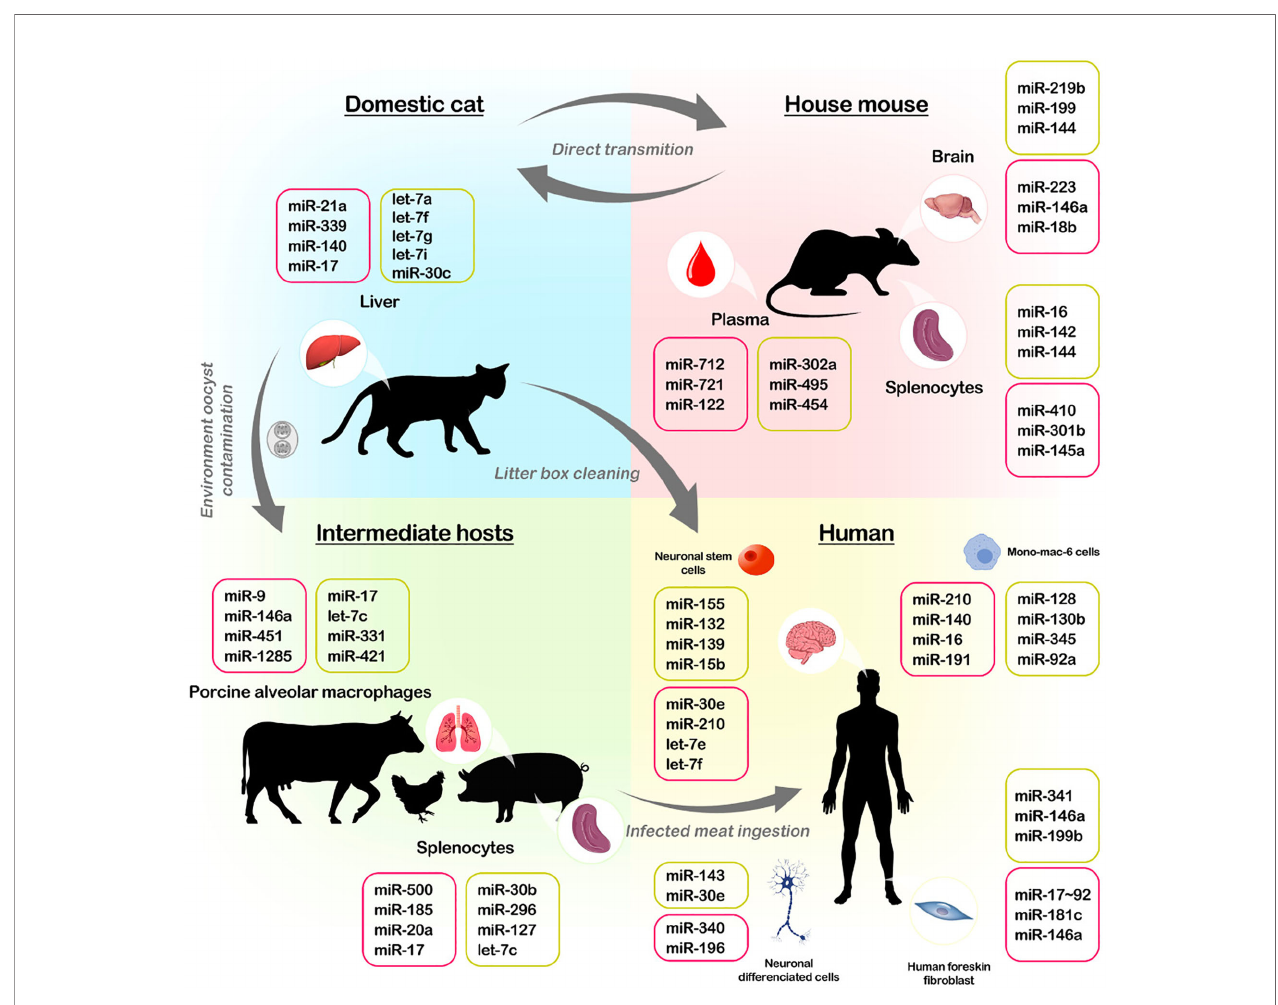
FIGURE 2 | Life cycle of Toxoplasma and host miRNA interaction. T gondii has a complex life cycle, in which the parasite can infect felids (domestic cats), farm animals, mice, and even humans. Felids are de fi nitive hosts. Oocysts are released from infected cat faeces and become infected in the environment after sporulate. Infected felids present modi fi cations in microRNA expressions. Humans become infected by ingestion of undercooked meat of infected animals or by the ingestion of soil, water or food contained sporulated oocysts derived from the environment. In the human host, the disease can affect various organs tissues such as skeletal muscle, brain (neuronally differentiated cells and neuronal stem cells) and myocardium, presenting modi fi cations in microRNA expressions. Also, porcine alveolar macrophages and splenocytes samples from infected pigs have modi fi ed microRNA pro fi les. Mice are used mainly to study toxoplasmosis in vivo because they may naturally be infected by the parasite and affect multiple organs while changing their microRNA pro fi le. These animals can also be having multiple organs affected by the infection, and it is known that the spleen, plasma, and brain have their miRNA pro fi le altered during the infection. The colour box represents the increase (pink) and decreases (yellow) of miRNA